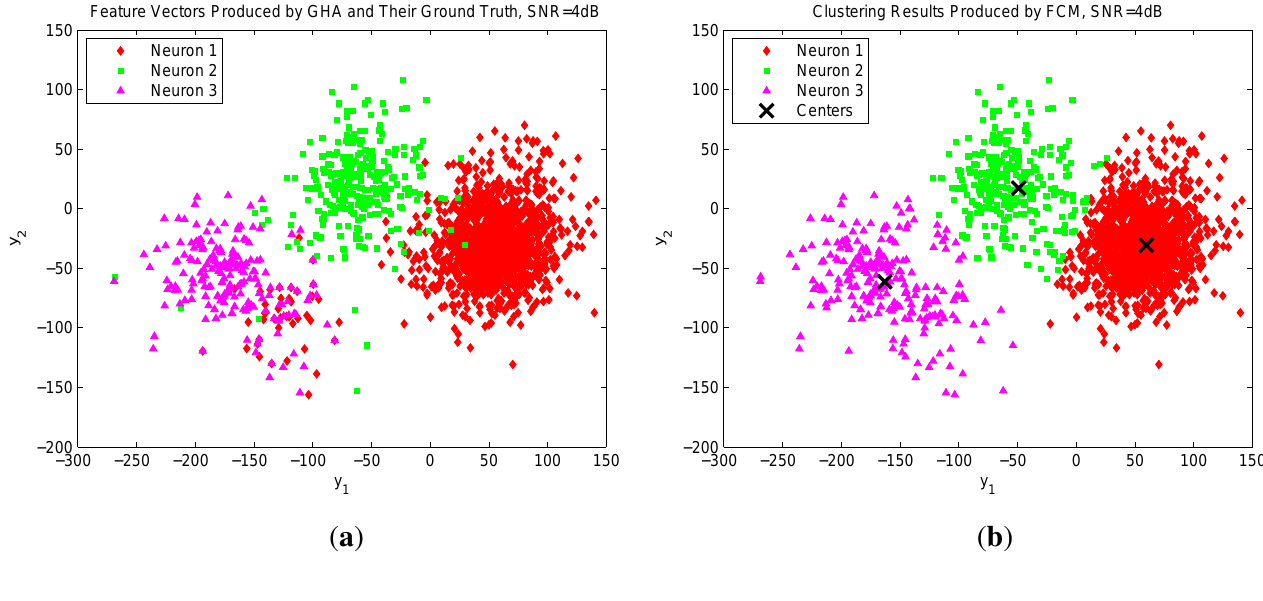
The CCRs of the GHA and FCM algorithms for different number interfering neurons.